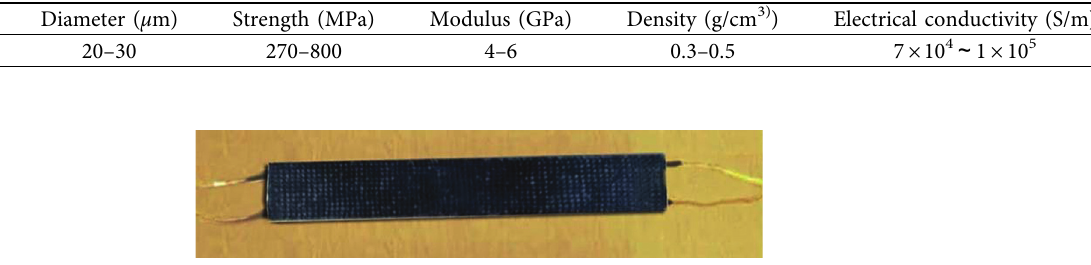
Figure 6: 3D braided composite